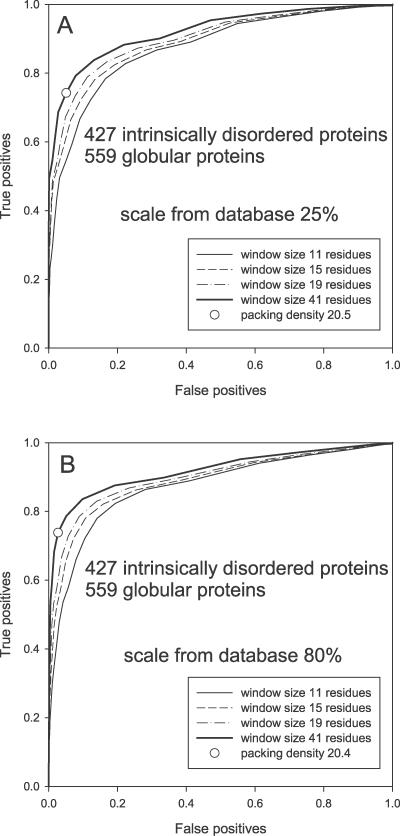
ROC Curves for Prediction of Intrinsically Disordered RegionsEach ROC curve corresponds to predictions with specified (on the legend) size of the sliding window. The open circle corresponds to the value of packing density that is chosen as a threshold, 20.5 for database 25% (A) and 20.4 for database 80% (B).